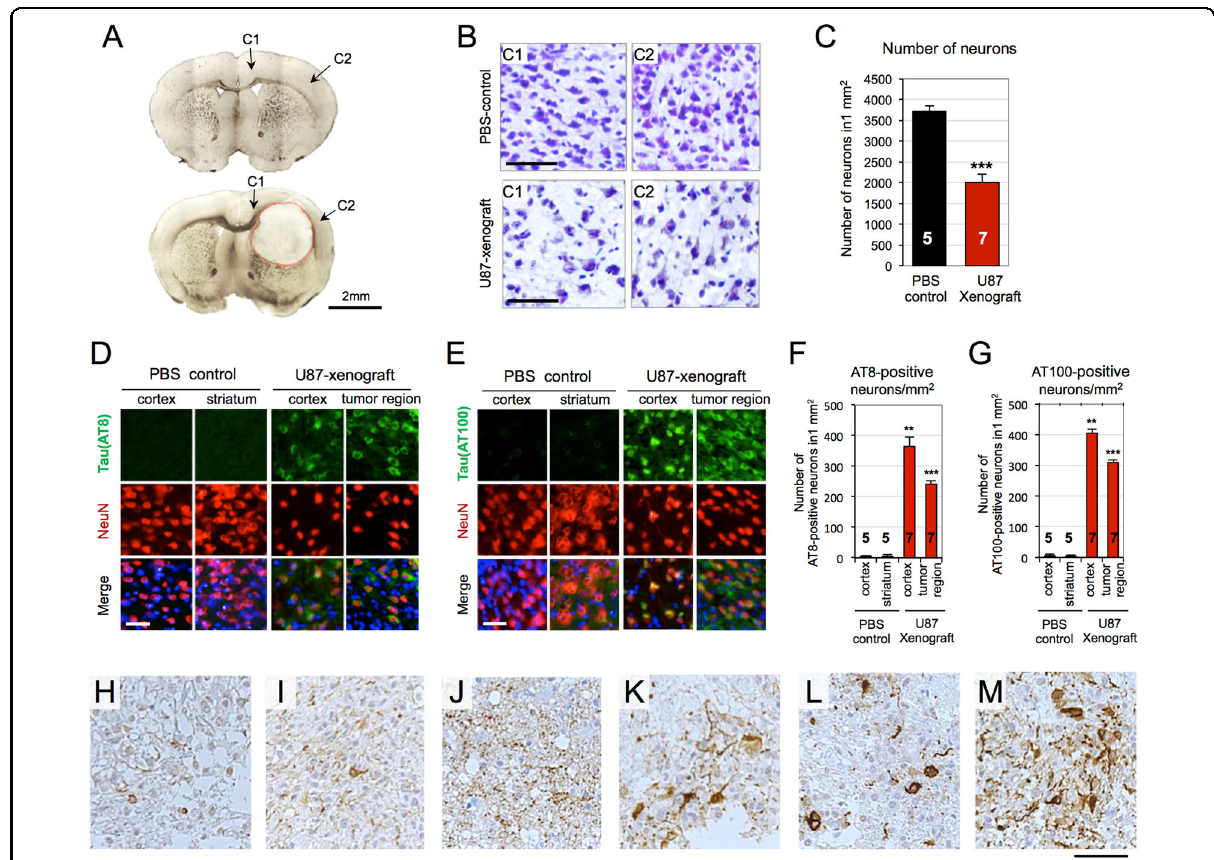
Fig. 1 Elevated tau pathology in U87-xenograft model and primary glioblastoma tissues. a Bright fi eld images of PBS-injected (up) and U87- xenograft (down) brain tissues. U87 cells were stereotaxically injected into the striatum of BALB/ c nude mice brain ( n = 7). PBS-injected mice were used as a negative control ( n = 5). After 4 weeks of tumorigenesis, brains were extracted and tissue sections were prepared. b Cresyl violet stained tissues of PBS-control and U87-xenograft. Degenerating neurons were observed in the cortical regions, designated as C1 and C2 in the U87-xenograft brain. Scale bar, 250 µm. c Number of neurons in the cortex. Bars indicate both the mean and standard deviation of the mean, *** P < 0.001. d , e Tau immuno fl uorescent images with anti-AT8 ( d ) and anti-AT100 ( e ) antibodies. Neuronal nuclei were counterstained with NeuN. Scale bar, 200 µm. f , g Numbers of AT8- and AT100-positive neurons in 1 mm 2 . h – m AT8 immuohistochemical stained images of human glioblastoma tissues ( n = 6). Paraf fi n-embedded tissue sections were stained with anti-AT8 antibody (brown). Nuclei were counterstained with Hematoxylin (blue). Scale